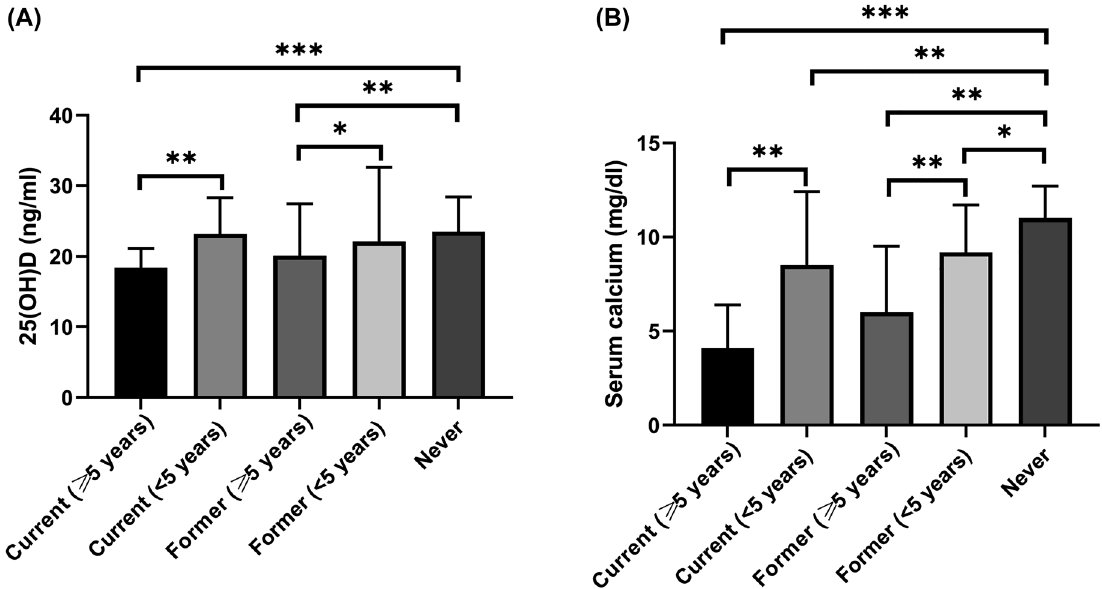
Figure 2: Mean concentrations of serum 25(OH)D (A) and calcium (B) in never-smokers, former smokers, and current smokers. The groups of former smokers and current smokers were further classi fi ed according to their smoking durations (<5 years and ≥ 5 years). The values were presented as means and standard errors. *p<0.05, **p<0.01,